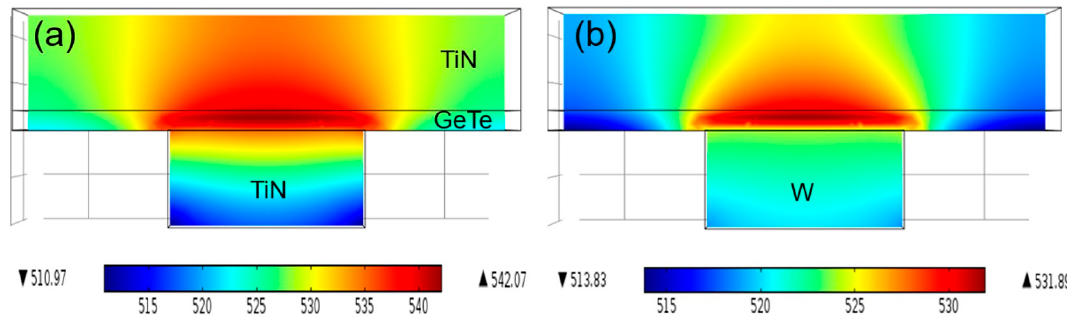
Figure 4. Temperature distribution (in Kelvin) in the device by electro-thermal simulation: ( a ) TGT and ( b ) TGW devices.